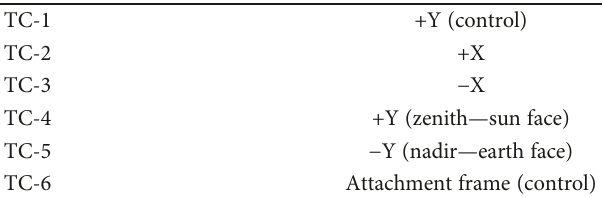
Table 7: Position of temperature